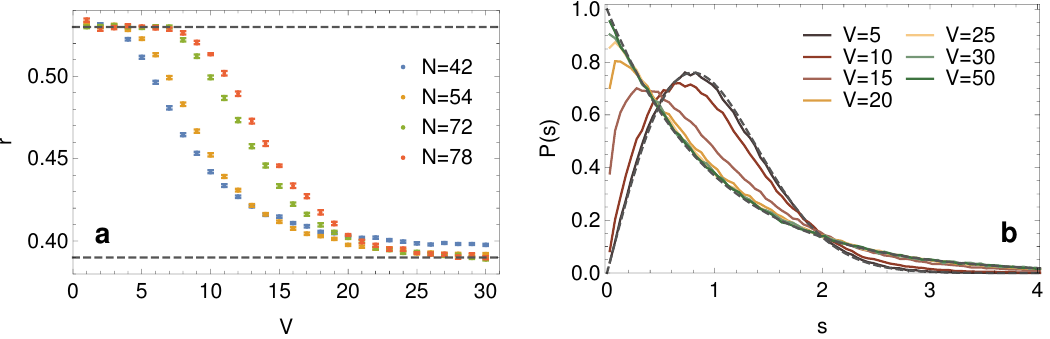
Figure 2: Panel a . Gap ratio r as a function of the disorder strength V for differ- ent honeycomb samples. The two limiting values at approximately 0.53 and 0.39 (dashed lines) correspond to the ones obtained for a Wigner-Dyson and Poisson dis- tribution respectively. Panel b . Distribution of the energy gaps s trum. The Wigner-Dyson and Poisson reference distributions are shown in dashed